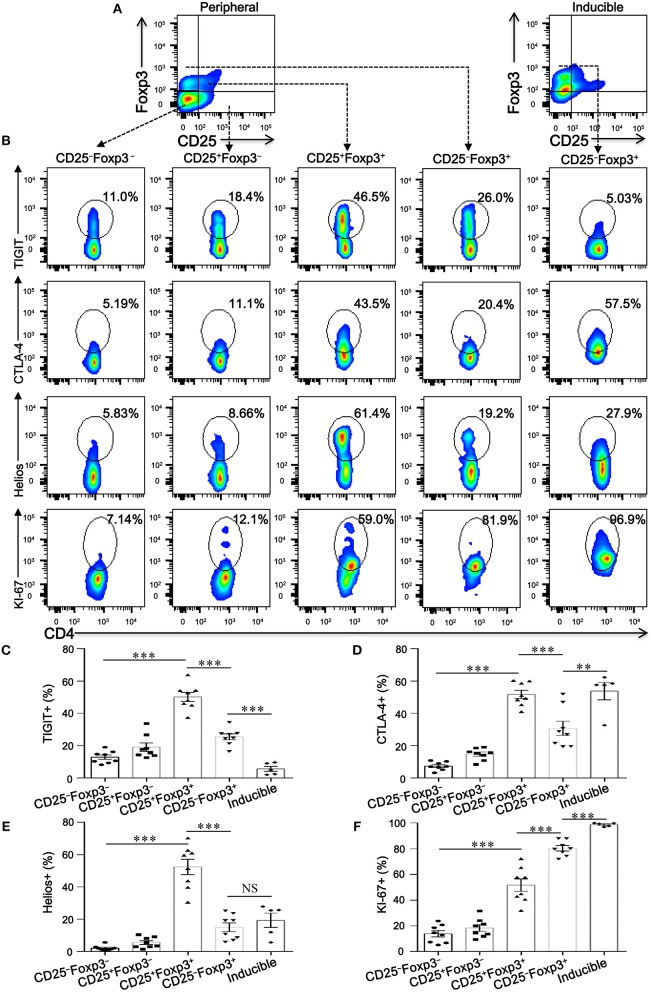
CD4+CD25−Foxp3+ T cells lose classical markers relevant to Tregs. (A) Gating strategy for CD4+ T cell subsets based on CD25 and Foxp3 expression. (B) Representative dot plots for the detection of the expression of the conventional Treg markers TIGIT, CTLA-4, Helios, and KI-67 amongst: peripheral CD4+ T cells subsets (CD4+CD25−Foxp3− T cells, CD4+CD25+Foxp3− T cells, CD4+CD25+Foxp3+ T cells and CD4+CD25−Foxp3+ T cells) from SCOPD patients (n = 8) and inducible CD4+CD25−Foxp3+ T cells (Inducible, n = 5). (C–F) Scatter plots depict the distribution of TIGIT, CTLA-4, Helios, and KI-67 in the five assessed CD4+ T cell subsets. Horizontal bars indicate means ± SEM. The comparisons among peripheral CD4+ T cells subsets from the same individual were made using two-tailed paired t-test; the comparisons between peripheral CD4+ T cells subsets and inducible CD4+CD25−Foxp3+ T cells were made using two-tailed unpaired t-test, **P < 0.01, ***P < 0.001.